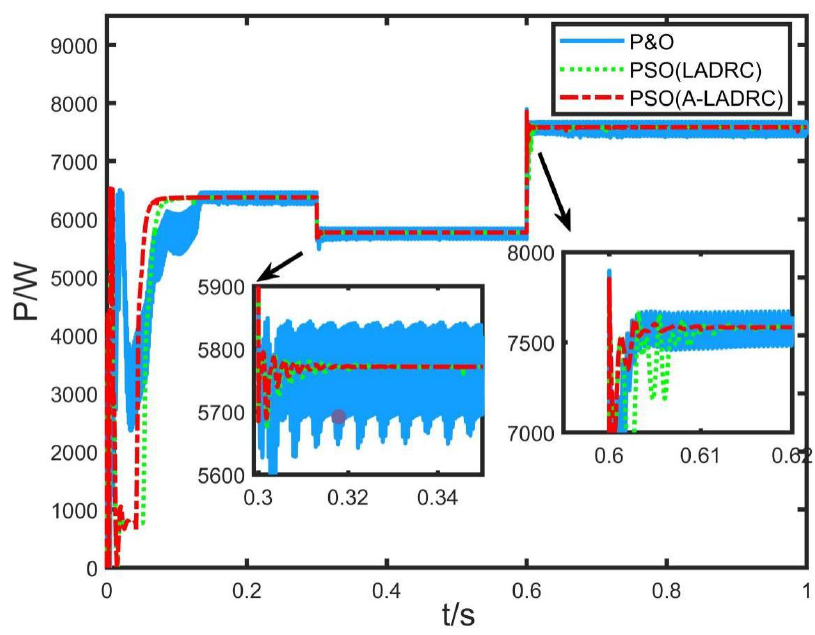
Figure 8. Output power of photovoltaic array when changing light intensity.